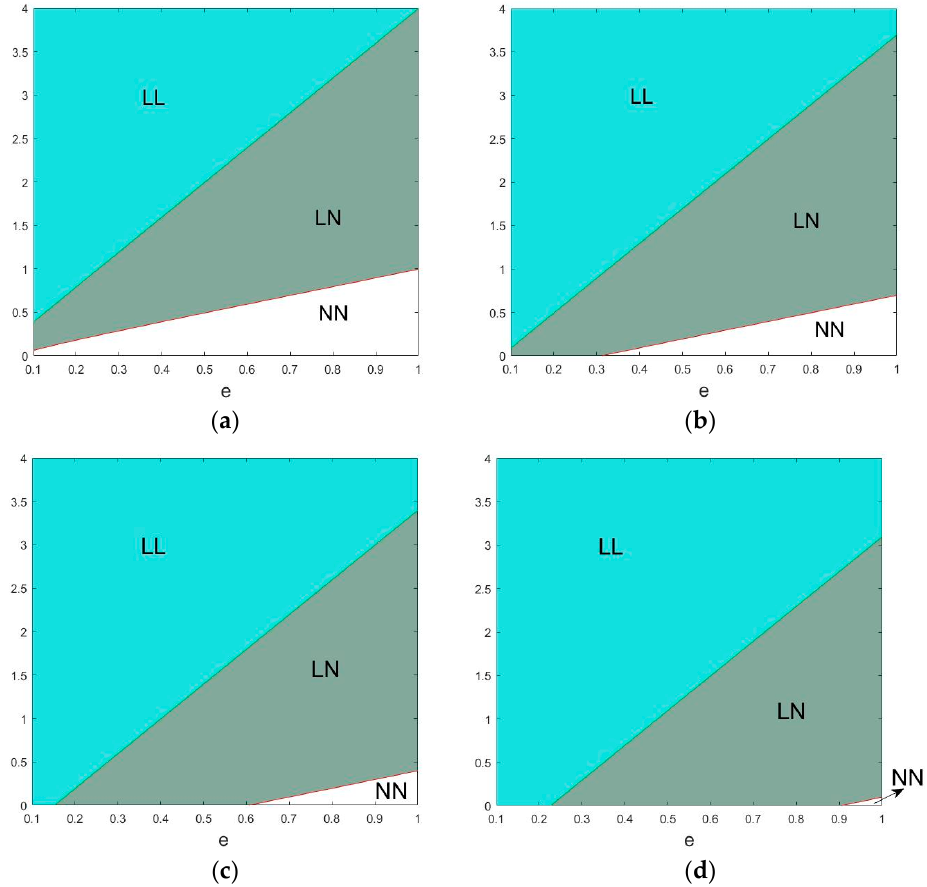
Figure 11. Changes of the market structure ( a ) λ = 0 ( b ) λ = 0.3 ( c ) λ = 0.6 ( d ) λ = 0.9.